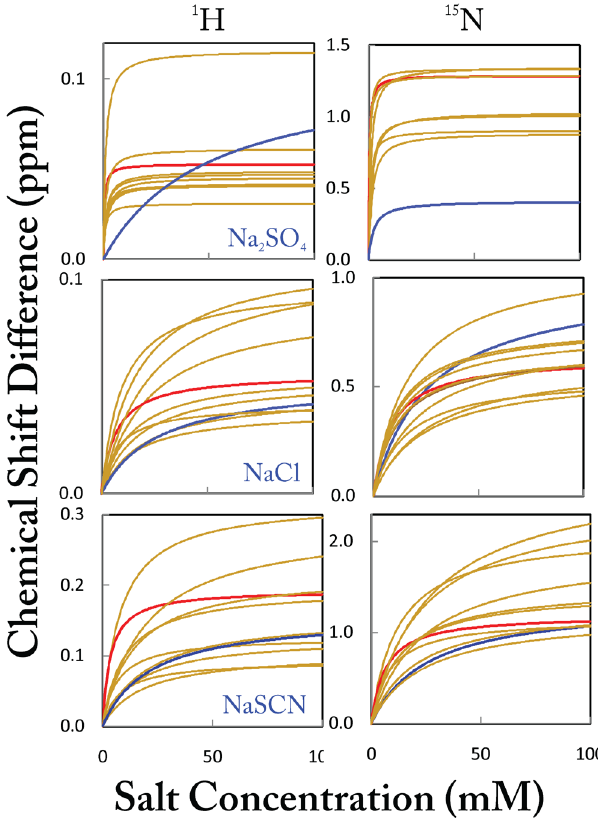
Figure 18. Apparent dissociation constants for specific anion- binding. The fitting curves for 1 H and 15 N chemical shift changes using the one binding site model for significant shifted residues of the entire ephrin-B2 cytoplasmic domain, which are induced by gradually adding Na SO , NaCl and NaSCN. The blue and red lines 2 4 are used to indicate the curves associated with the highest and lowest Kd values,